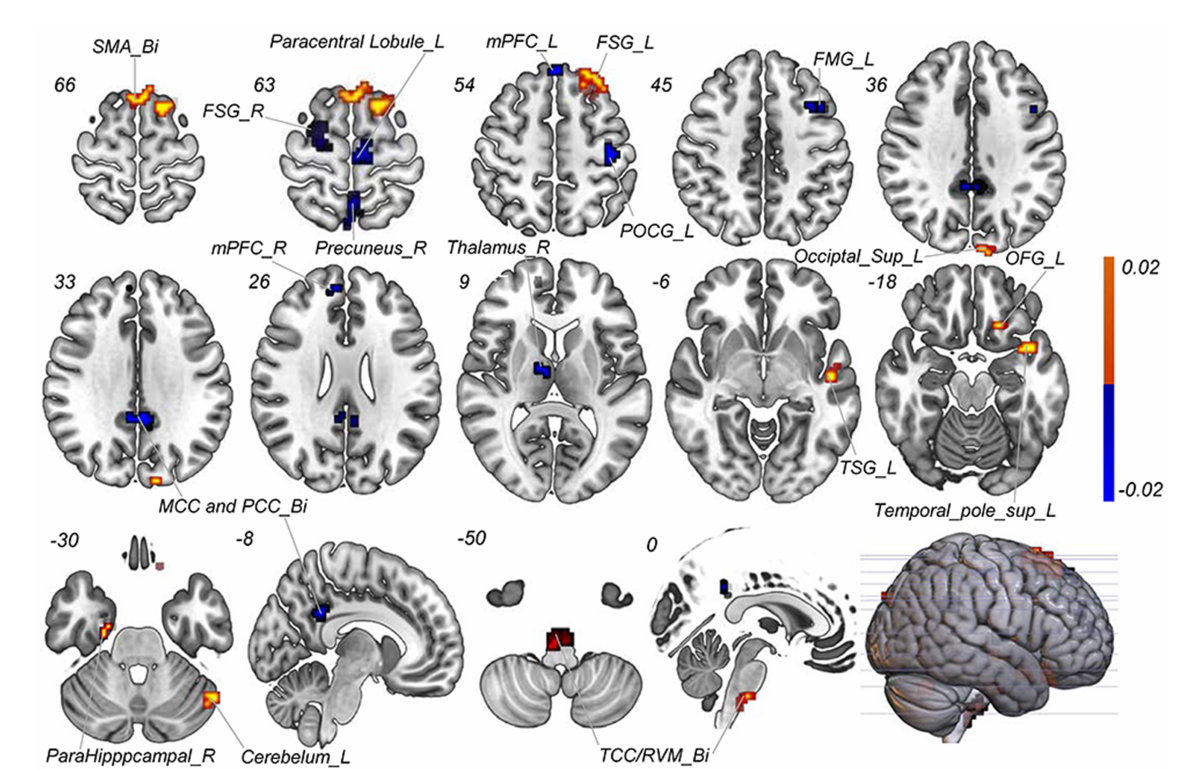
FIGURE3 Discriminative features to discriminate MWoA patients and HCs. Red means positive weight and blue means negative weight. The main weight brain areas were located in TCC/RVM, thalamus, PFC, and TSG/TMG. Bi, bilateral; FMG, frontal middle gyrus; FSG, frontal superior gyrus; L, left; MCC, middle cingulate cortex; mPFC, medial prefrontal gyrus; OFG, orbitofrontal gyrus; PCC, post cingulate cortex; POCG, postcentral gyrus; R, right; RVM, rostral ventromedial medulla; SMA, supplementary motor area; Sup, superior; TCC, trigeminal cervical complex; TMG, middle temporal gyrus; TSG, superior temporal